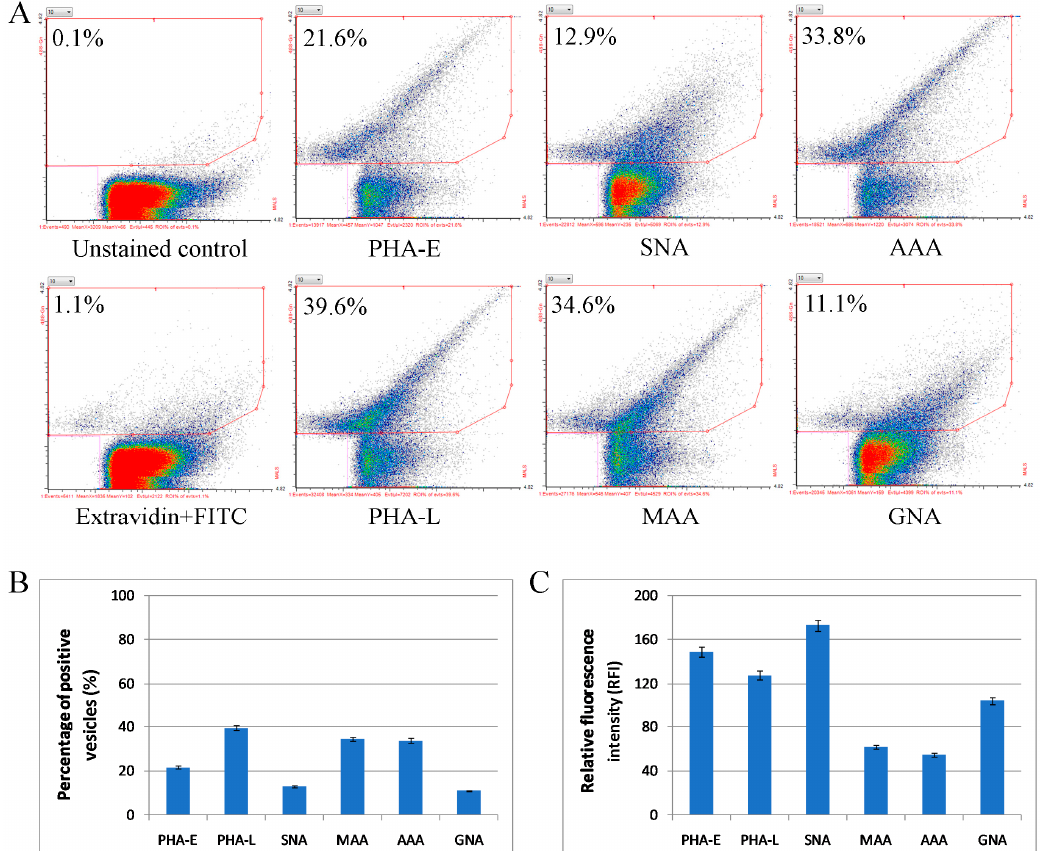
Figure 7. Flow cytometry analysis of surface glycosylation of Mel202-derived ectosomes. ( A ) Dot plots for MAA-, SNA-, GNA-, AAA-, PHA-E-, and PHA-L-positive ectosomes. Results for unstained control and control secondary extravidin-FITC staining are also provided. The x-axis shows values obtained using medium angle light scatter (MALS) and the y-axis shows log fluorescence intensity measured on 488Gn laser. ( B ) Diagram showing the percentage of positive ectosomes in each staining calculated via the subtraction of the value for the unspecific binding (secondary FITC-extravidin staining) from the raw value for each lectin staining. ( C ) Diagram showing the relative fluorescence intensity (RFI) for each staining.